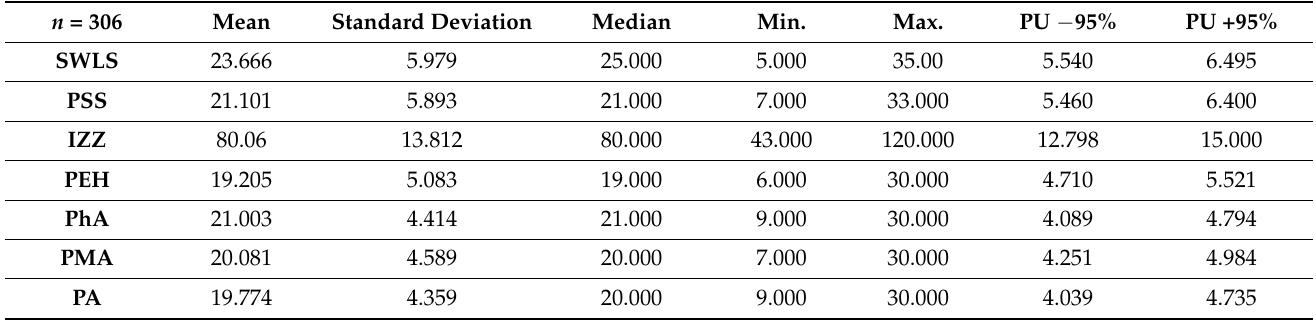
Table 2. Descriptive statistics of variables for the test